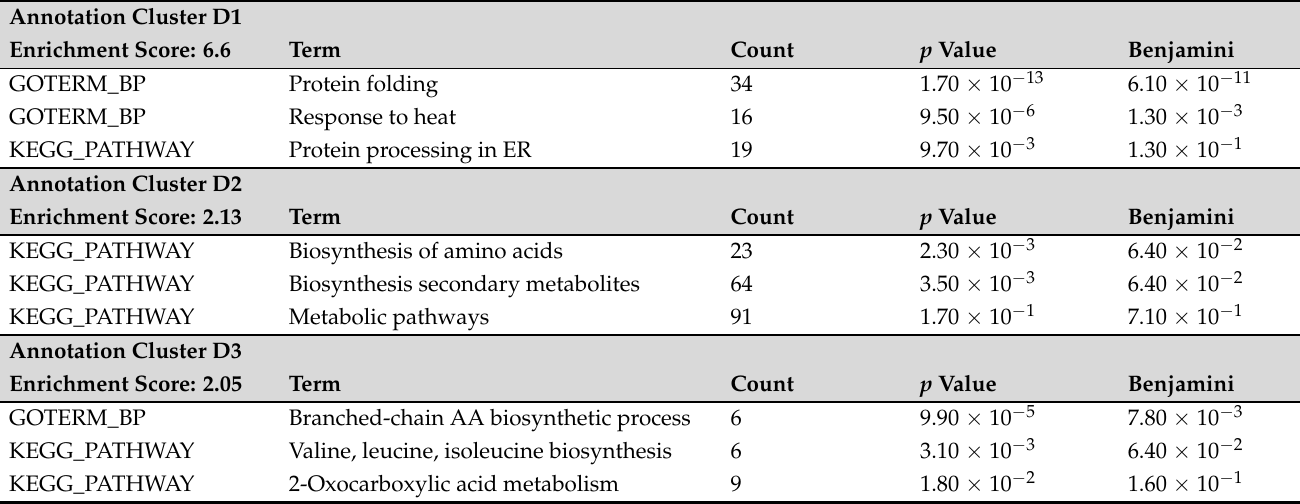
Table 1. Functional Annotation Clustering by GO_Biological Function and KEGG pathway of the proteins only present or more persulfidated in dark collected sample